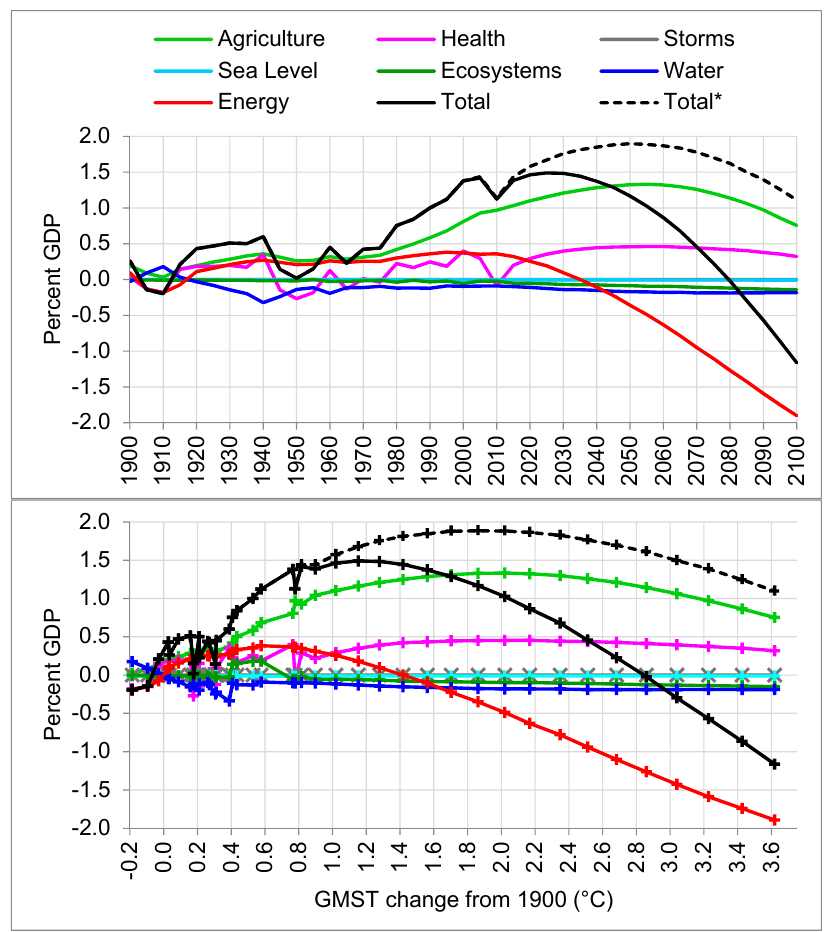
Figure 1. “The global average sectoral economic impact of climate change in the 20th and 21st century as functions of time (top panel) and temperature (bottom panel)” [12]. Total is of all impact sectors. Total* is of all impact sectors from 1900 to 2000, and of all sectors except energy from 2000 to 2100. (Adapted from Figure 3 in Tol [12] by permission from Springer